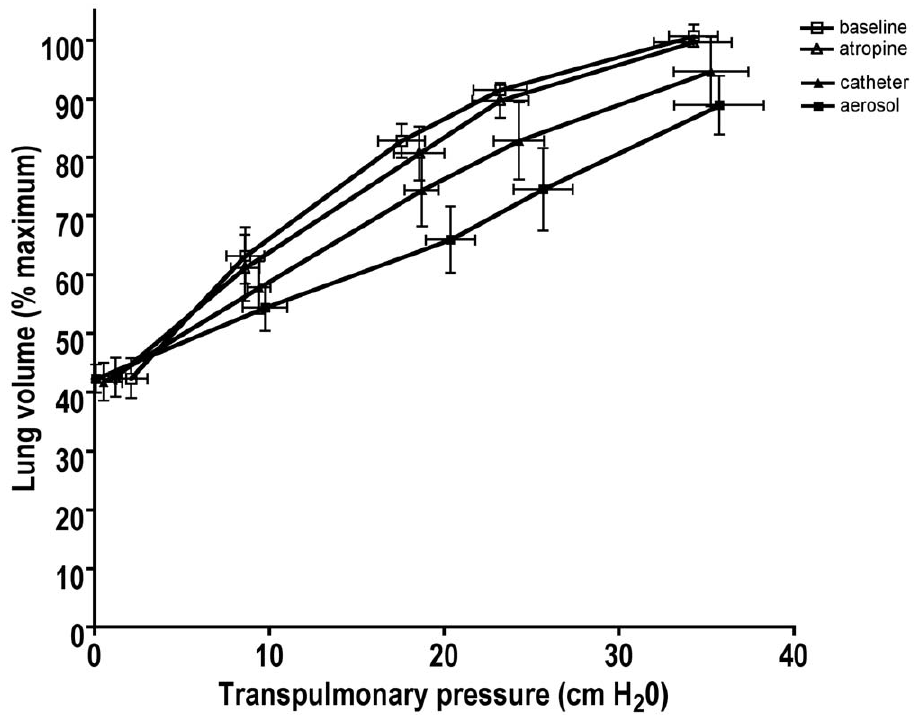
Figure 3. The mean ( ± SEM) lung volume (as a percentage of the maximum lung volume) and transpulmonary pressure (cm H 2 O) at each airway pressure (0, 12, 25, 32, and 45 cm H 2 O) under the four conditions: baseline (before aerosol, open squares), atropine (before catheter, open triangles), aerosol histamine challenge (black squares), and individual airway catheter challenge (black triangles) among four dogs. Transpulmonary pressure increased significantly with airway pressure (p , 0.0001) in all four states, and there were no differences in transpulmonary pressures among the four states at any fixed level of airway pressure (p=0.38).